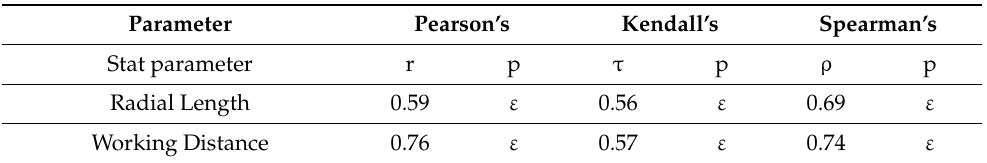
Table 2. Correlation coefficients of uniform model for radial measurement error. The symbol ε denotes a p < 0.0001.